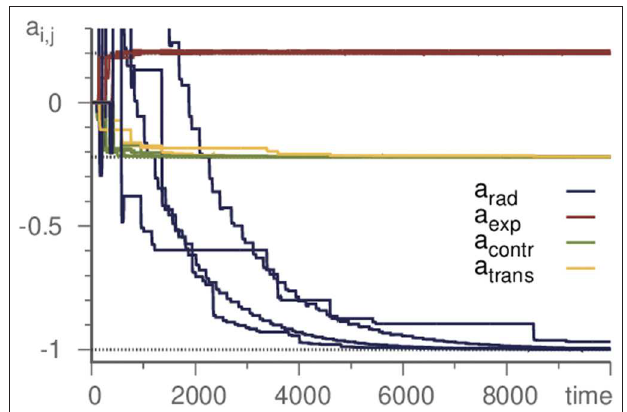
FIGURE 4 | Influence of the noise strength on the template system during learning a Kirk-Silber network. Plotted are the contracting eigenvalues during learning. The master system has always σ template contracting eigenvalues fluctuate. Parameters are ϑ ρ =